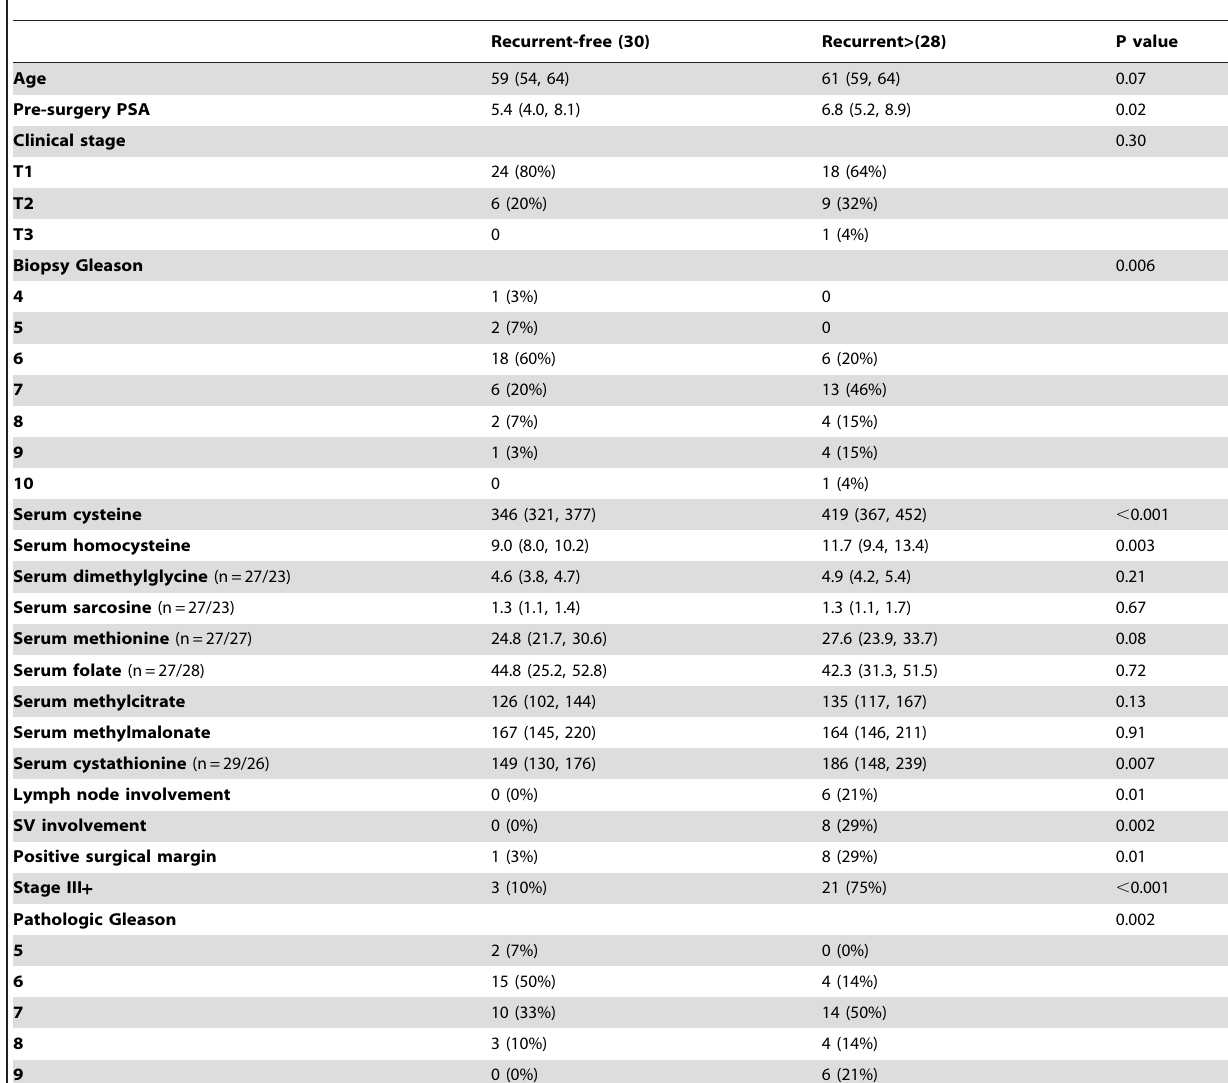
Table 2. The values for methionine metabolites measured in the sera of the recurrent-free and the recurrent groups are compared.